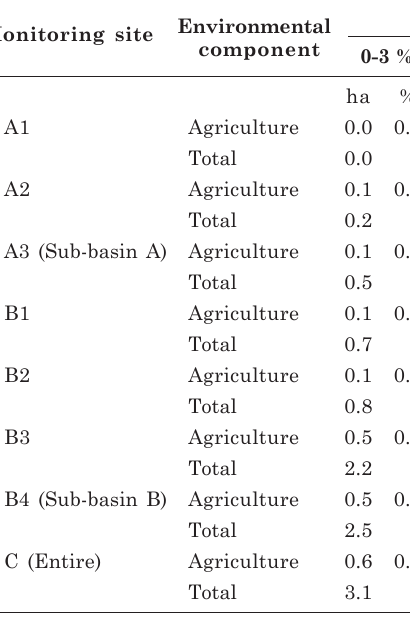
Table 4. Slope and land use in the Campestre